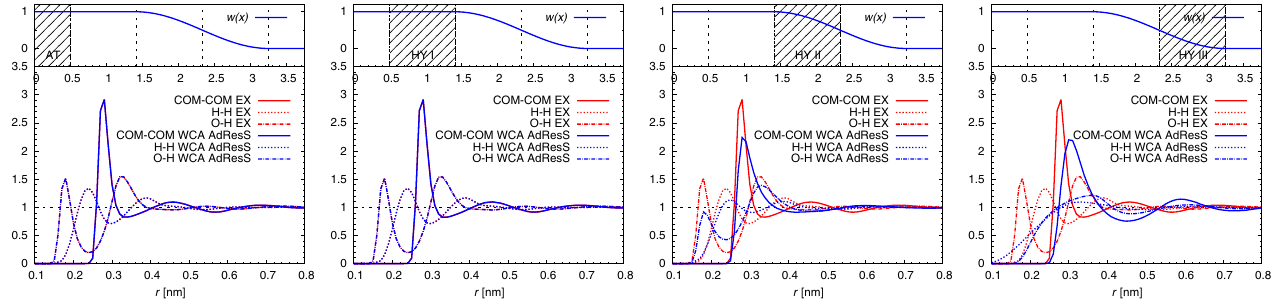
FIG. 6. The COM-COM, H-O, and H-H RDFs. The red line is the curve that corresponds to the EX. The curve obtained by employing the WCA AdResS method is represented in blue. The hybrid region is equally divided into three parts: HY I, HY II, and HY III, the widths of which are roughly equal to the cutoff radius, i.e., 9 nm. The top part of each panel shows the region where the g ð r Þ is calculated and the value of the weighting function w ð x Þ in each region. From left to right, the panels correspond to the AT region, the HY I subregion of (cid:1) , the HY II subregion of (cid:1) , and the HY III subregion of (cid:1) ,